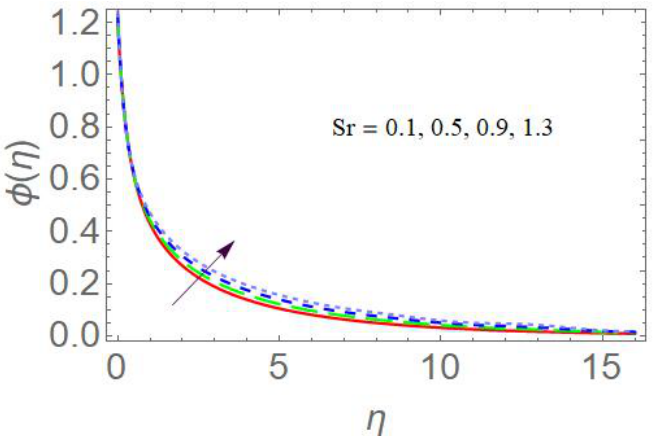
Figure 5. Impacts of Sr on φ ( η ) .